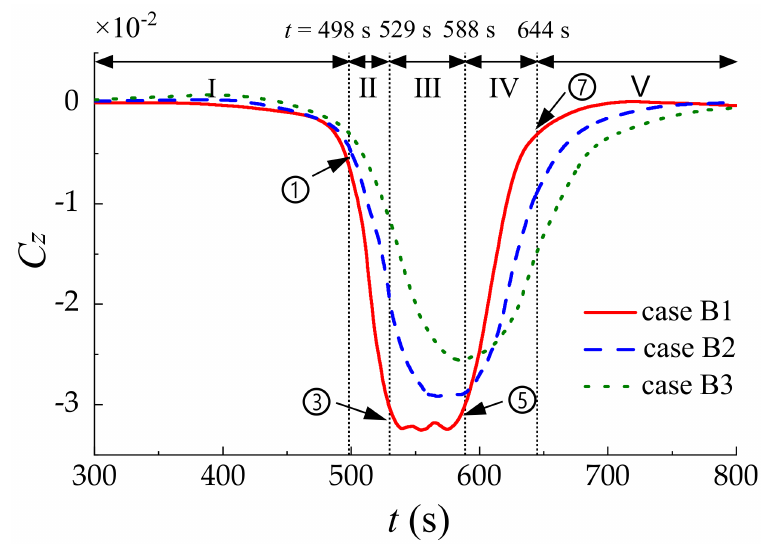
Figure 13. Time series of vertical force with different thicknesses of the pycnocline.